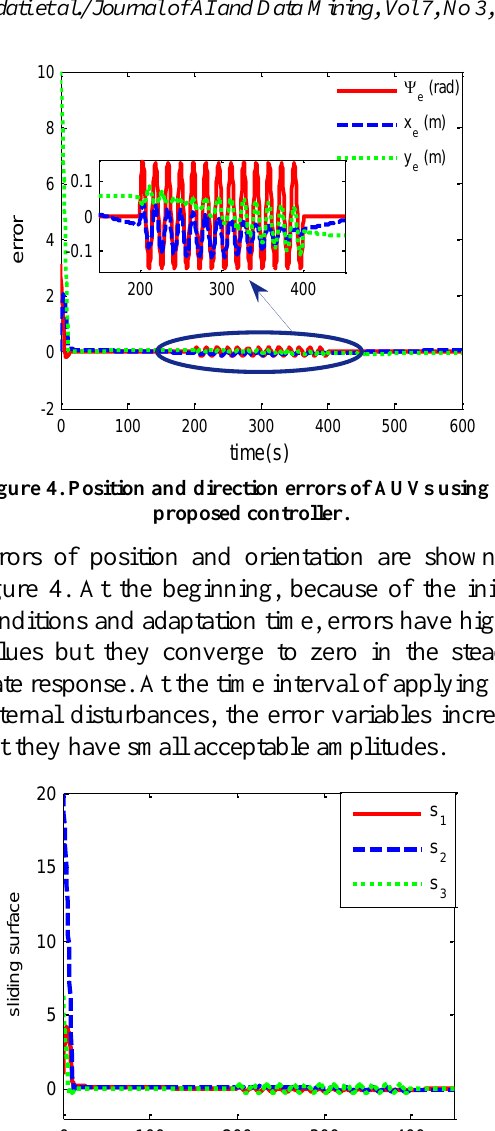
Figure 8. Control efforts of the proposed controller.